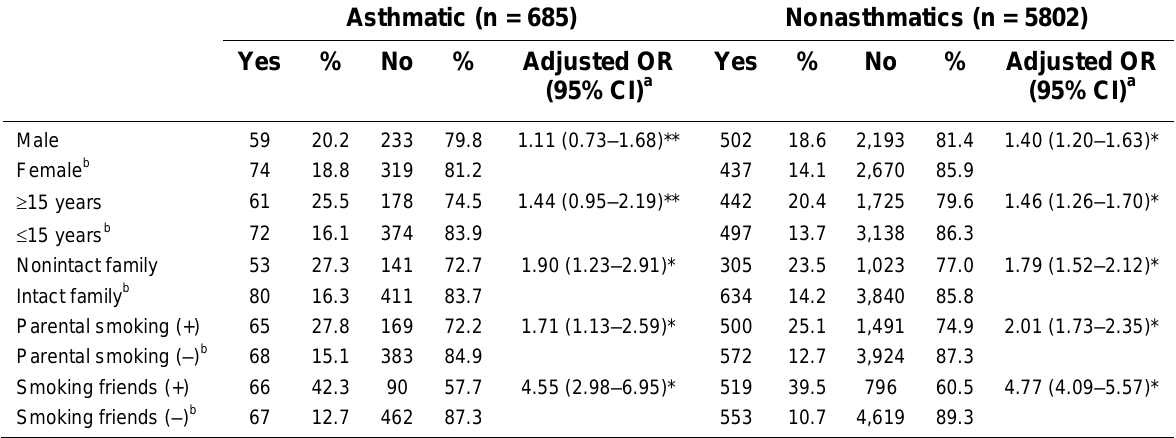
Effect of Gender, Age, Family Structure, Parental Smoking, and Smoking Friends on Smoking among Adolescents With and Without Asthma Asthmatic (n =